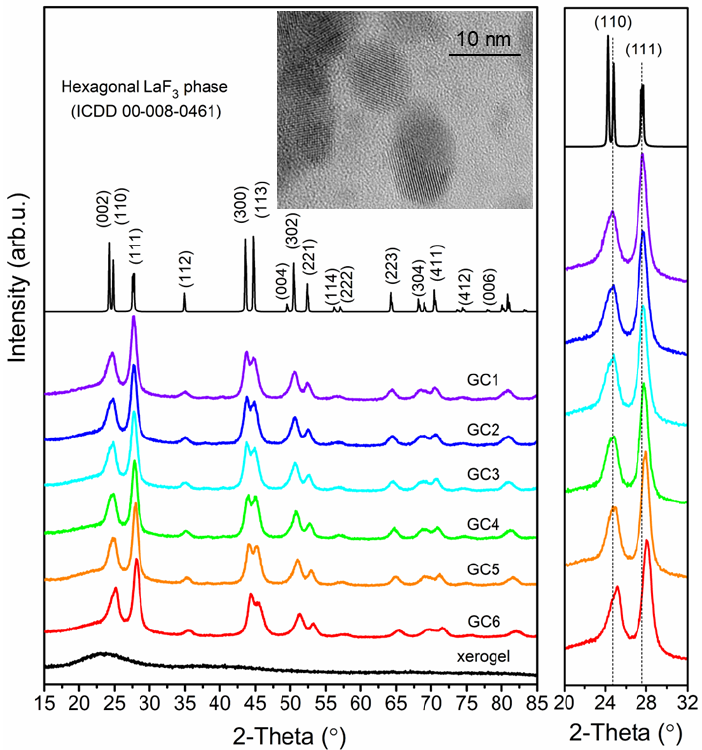
Figure 2. XRD patterns for the series of fabricated sol-gel samples. The region between 20° and 32° was enlarged to show the impact of Dy 3+ content on diffraction lines shifting. The inset shows HR-TEM image of GC1 sample. Table 2. Crystal lattice parameters of LaF 3 phase in prepared SiO 2 -LaF 3 :Dy 3+